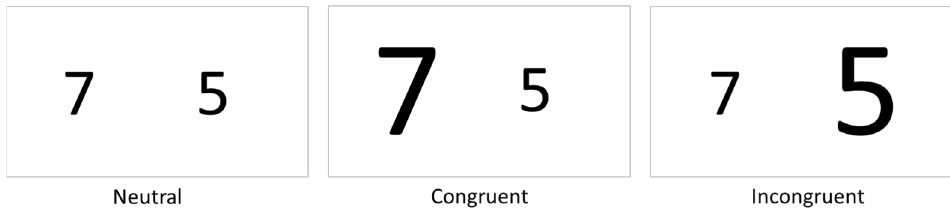
Figure 4. The three conditions of the numerical Stroop test that will be performed on smartphone.